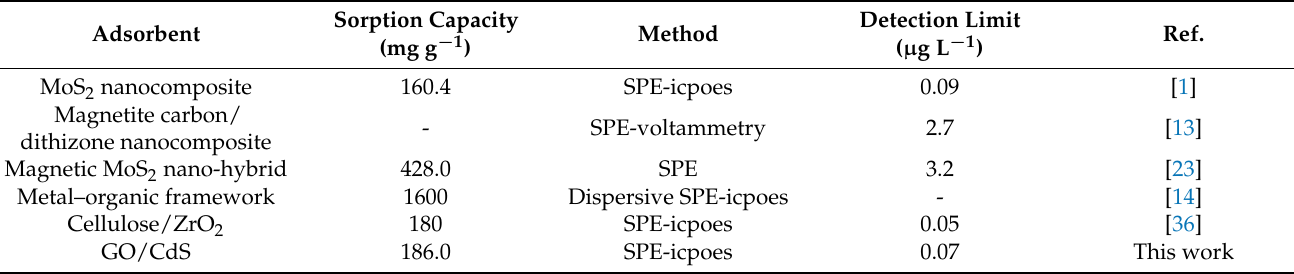
Table 5. Comparative data of analytical features of the reported